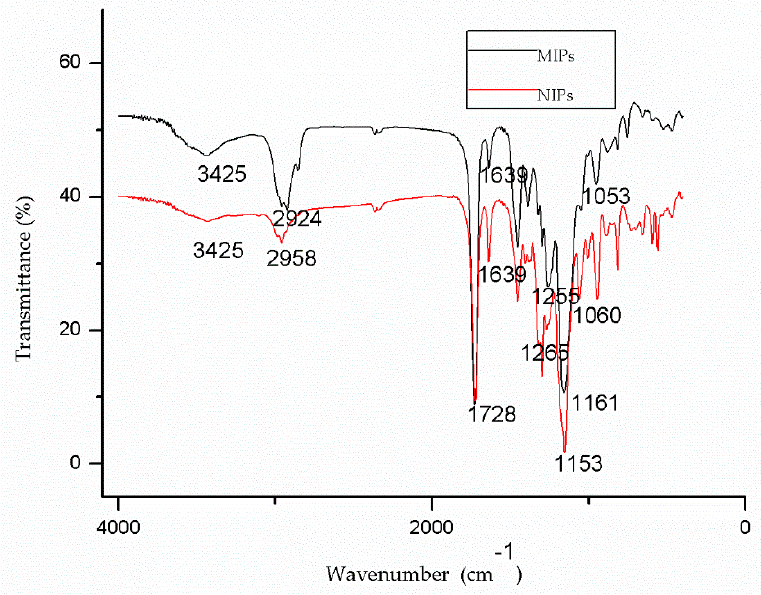
Figure 5. The FT-IR spectra of the MIPs and NIPs.